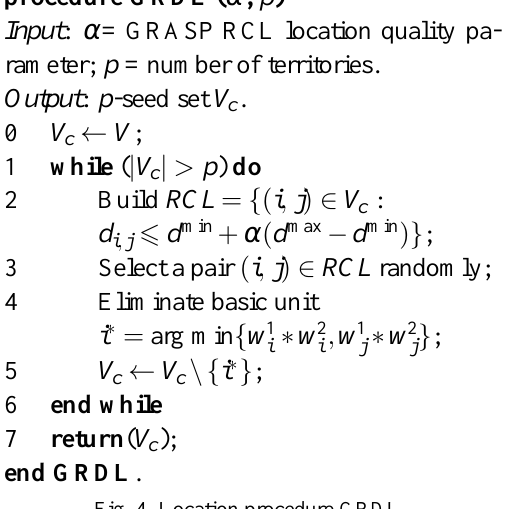
Fig. 4. Location procedure GRDL.